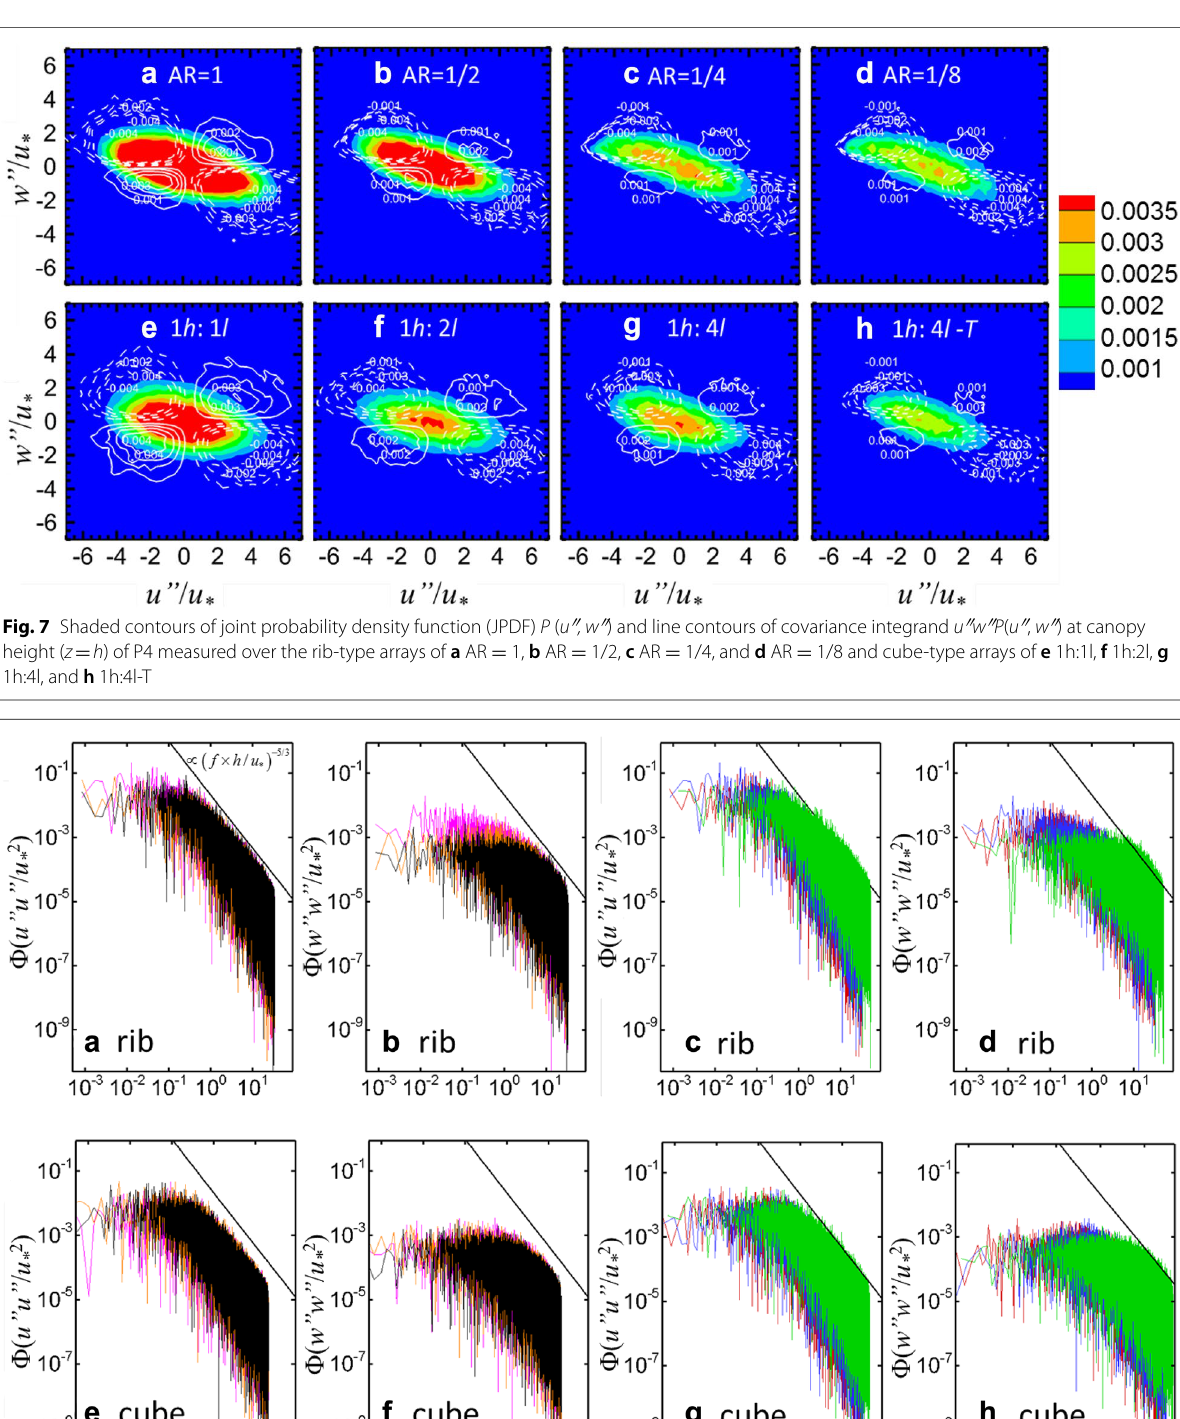
Fig. 8 Frequency spectra of dimensionless streamwise Φ ( u ″ u ″ / u * 2 ) and vertical Φ ( w ″ w ″ / u * 2 ) turbulence intensities at canopy level z hypothetical urban areas. a , b Are ribs of AR 1/4 and ( e , f ) are cubes for l: 4 h measured at P1 (black), P2 (orange), P4 (magenta). c , d Are ribs for = AR AR 1/2 (green), AR 1/4 (blue), and AR 1/8 (red) measured at P4. g , h Are cubes for h: 1 l (green), h: 4 l (blue), and h: 4 l = = = =